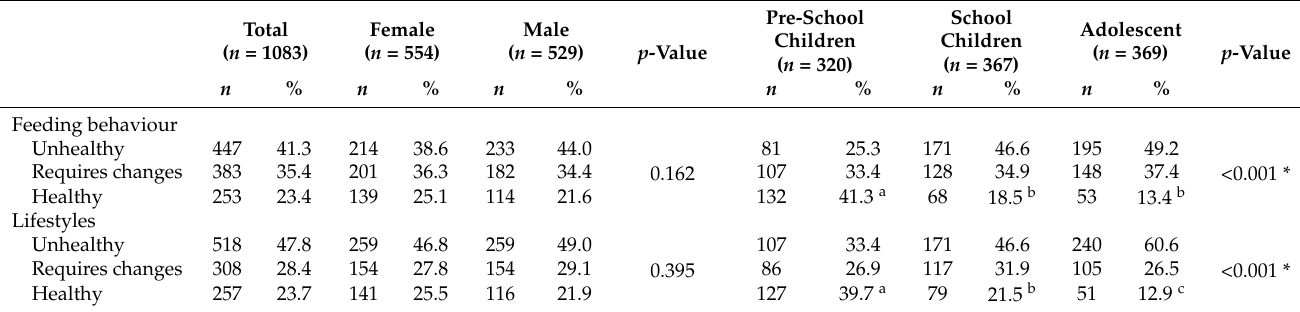
Table 3. Feeding behaviour and lifestyle by sex and age range of children and adolescents.